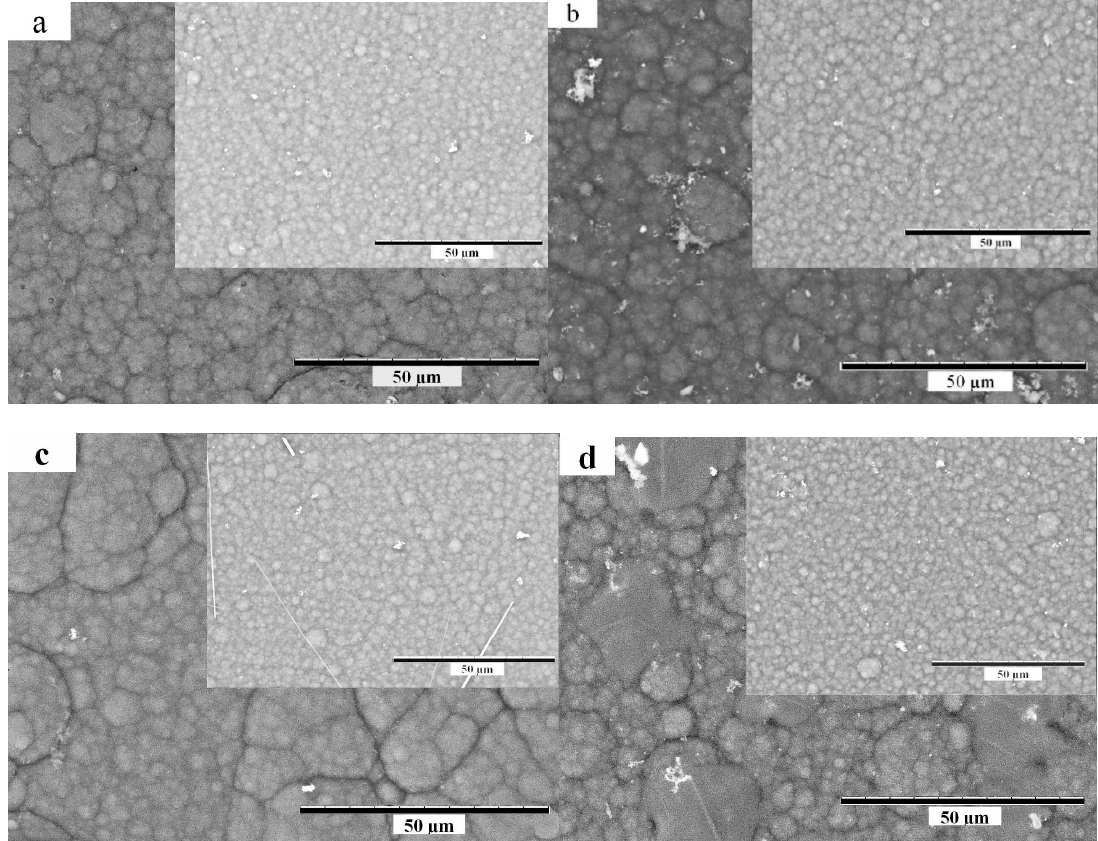
Figure 2. Scanning electron microscopy (SEM) surface images (scale bar 50µm) of PPy-PEO/DBS (inset PPy/DBS) after actuation cycles (stored in oxidized state of 0.65 V) in aqueous electrolyte ( a ): LiCF 3 SO 3 , ( b ): NaCl, ( c ): EDMICF 3 SO 3 and ( d ):